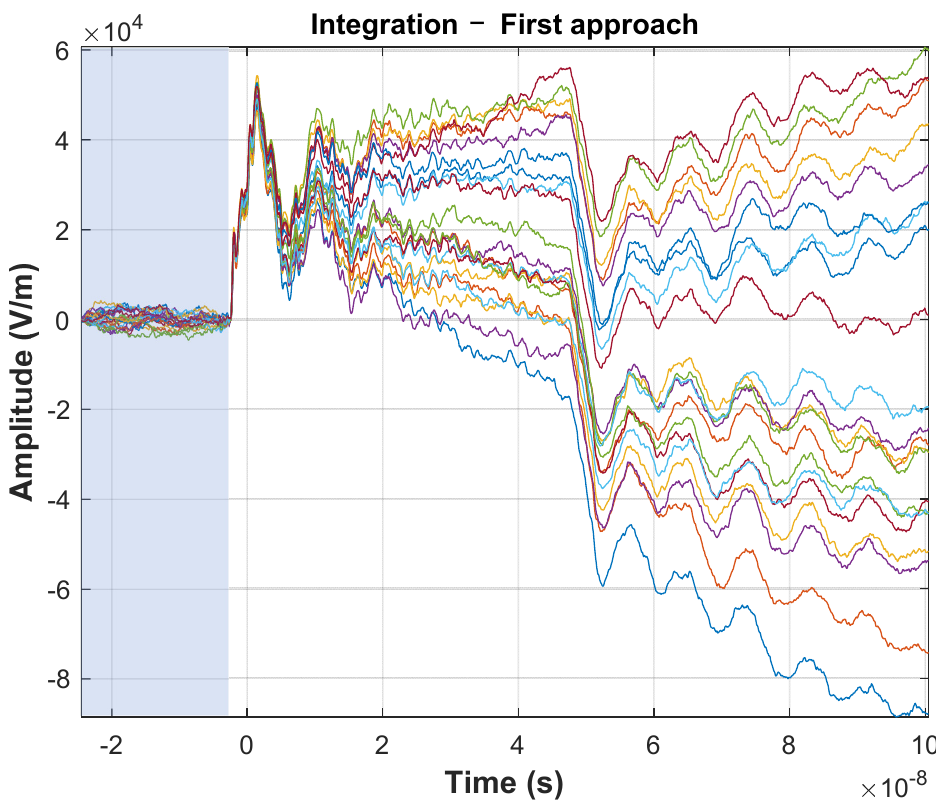
Figure 6. Integrated signal with mean value computed only for the pre-trigger region (blue region) and subtracted from signal only in that region.